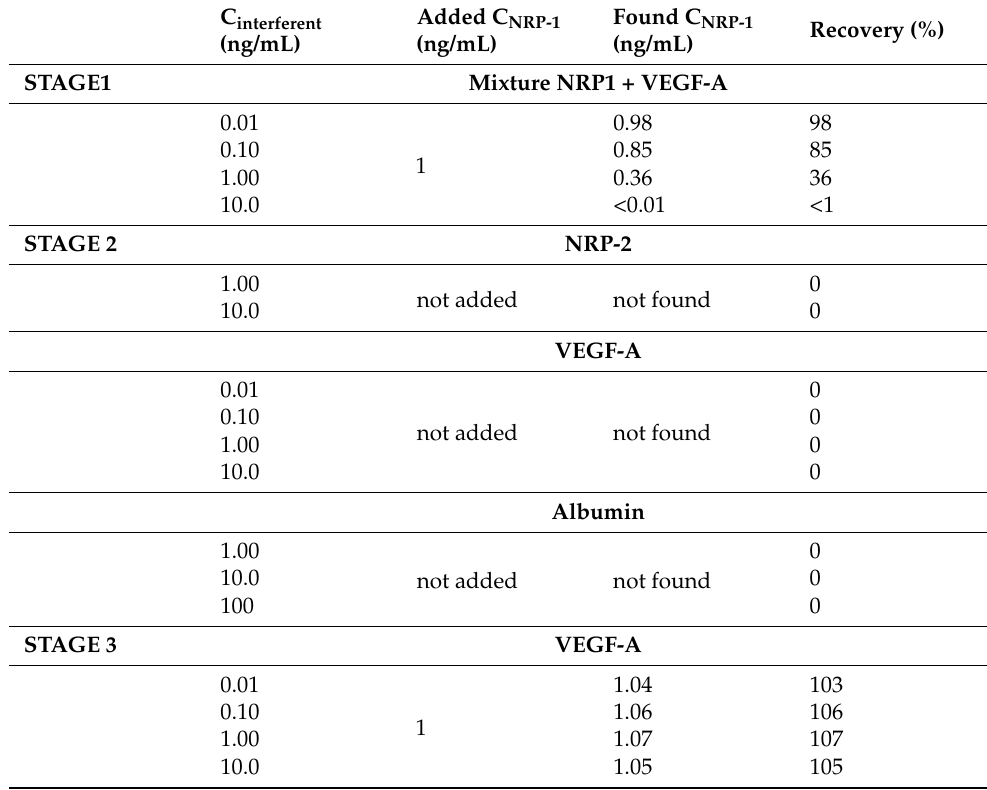
Table 3. Analytical specificity of the developed biosensors. C interferent